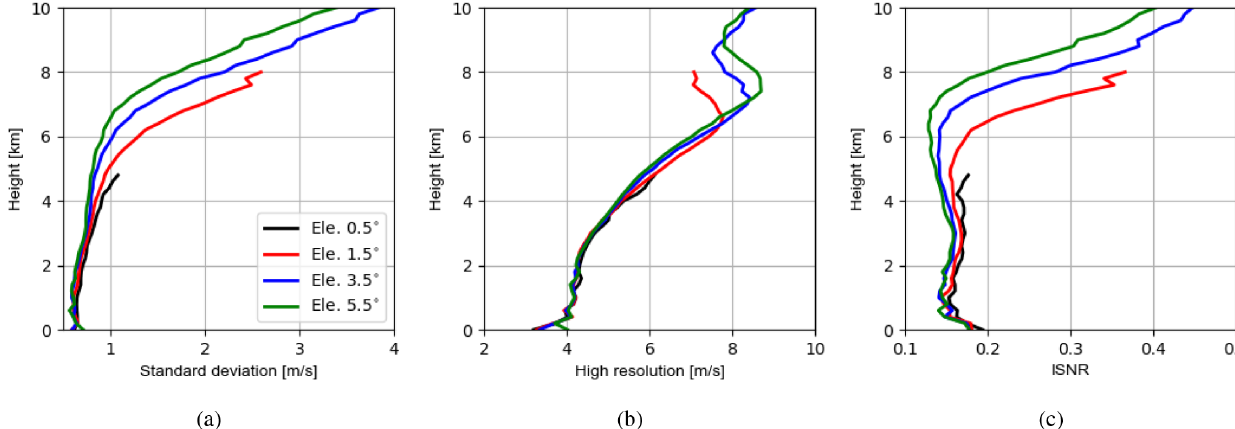
Figure 7. The same as Fig. 4 but for radial